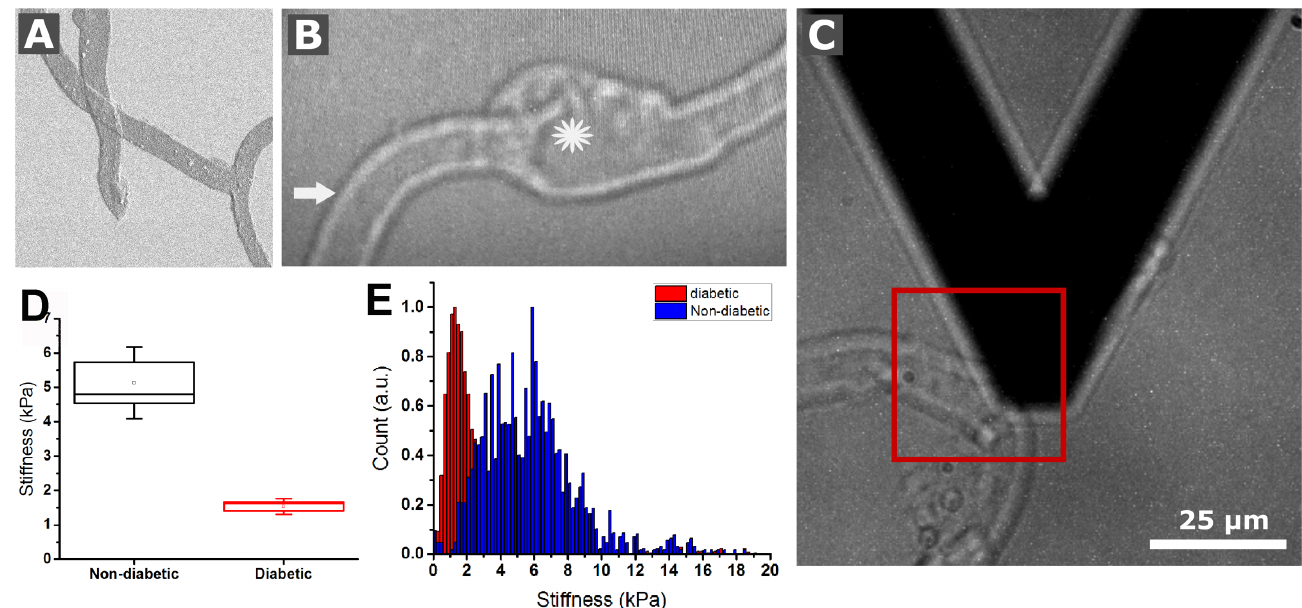
Fig 5. Biomechanical testing of human retinal vascular BM whole mounts by AFM. (A) Image shows a SEM micrograph of flat-mounted vascular BM sheets. (B) A representative light micrograph from a flat-mounted capillary during AFM measurements is shown. The star hereby marks an aneurism while the arrow indicates the region of AFM data collection on the sample surface in order to probe the biomechanical stiffness of a capillary. (C) Panel shows the AFM probe next to a capillary that was about to be probed in the indicated box. The box plot in (D) contrasts the average stiffness of non-diabetic and diabetic vascular BMs, respectively. Representative graphs show the relative frequency of AFM stiffness values for non-diabetic vascular BMs and diabetic vascular BMs (E).